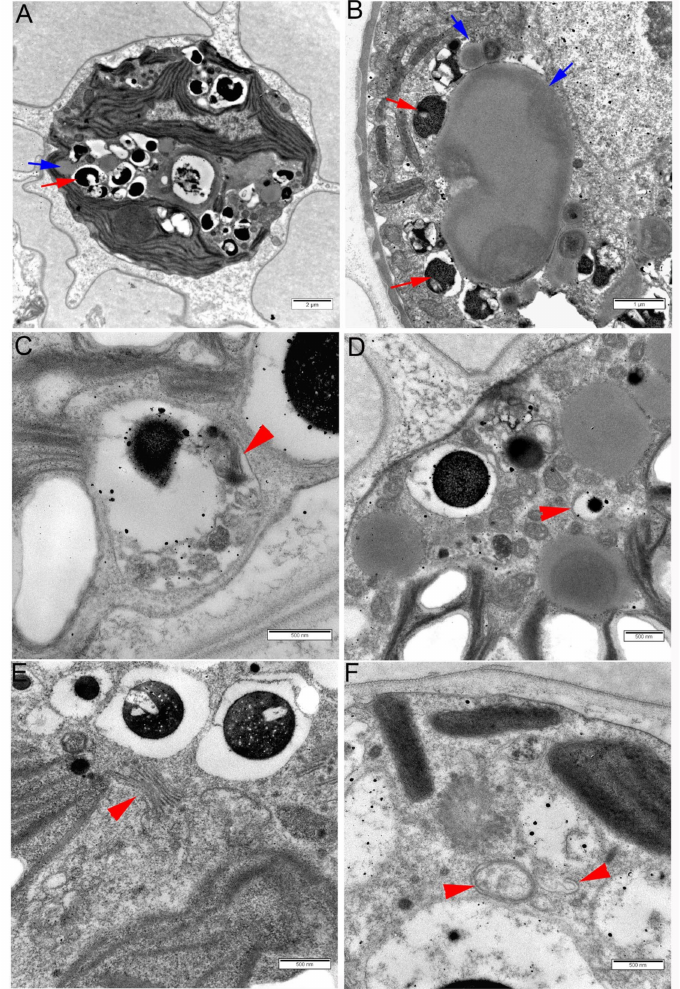
Figure 6. Ultrastructure of cells of Haematococcus lacustris cultures after three days of exposure to 0.8% NaCl. ( A ) A whole cell; red arrow points at an osmiophilic granule probably containing carotenoids including astaxanthin; blue arrow points at a lipid droplet. ( B ) Part of a cell showing lipid droplets (blue arrows) with ‘carotenoid bodies’ docking on them (red arrows). Osmiophilic ‘carotenoid bodies’ are located within single-membrane small vacuoles probably representing autolysosomes. ( C ) An autolysosome containing thylakoid remnants (red arrowhead). ( D ) Part of a cell showing electron- translucent lipid droplets, an electron-dense osmiophilic ‘carotenoid body’ within an autolysosome, and a small ‘carotenoid body’ surrounded by a double-membrane autophagosome (red arrowhead). ( E ) Several ‘carotenoid bodies’ in the vicinity of Golgi cisternae (red arrowhead). ( F ) Autophagosome (left red arrowhead) and a structure probably representing an omegasome with an expanding phagophore (right red